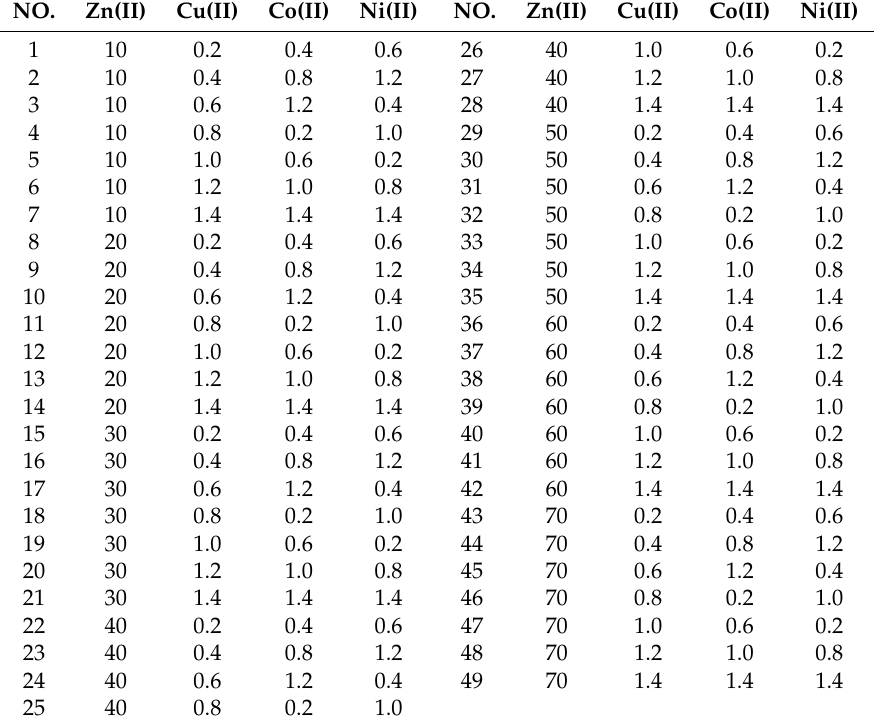
Table 1. The concentration of Zn(II), Cu(II), Co(II), and Ni(II) of 49 samples